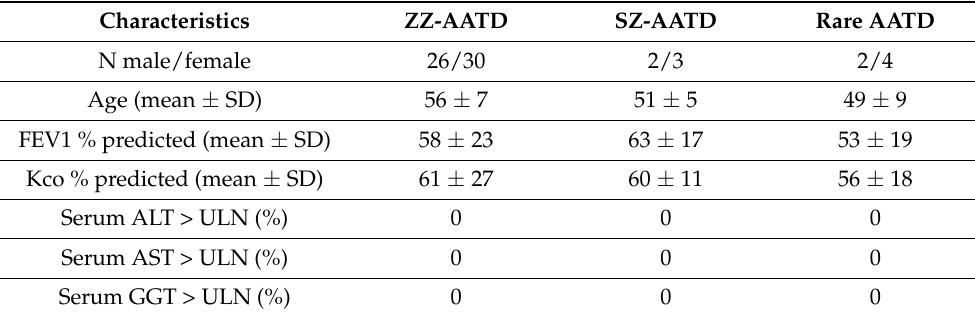
Table 1. Characteristics of the pulmonary patient cohort.